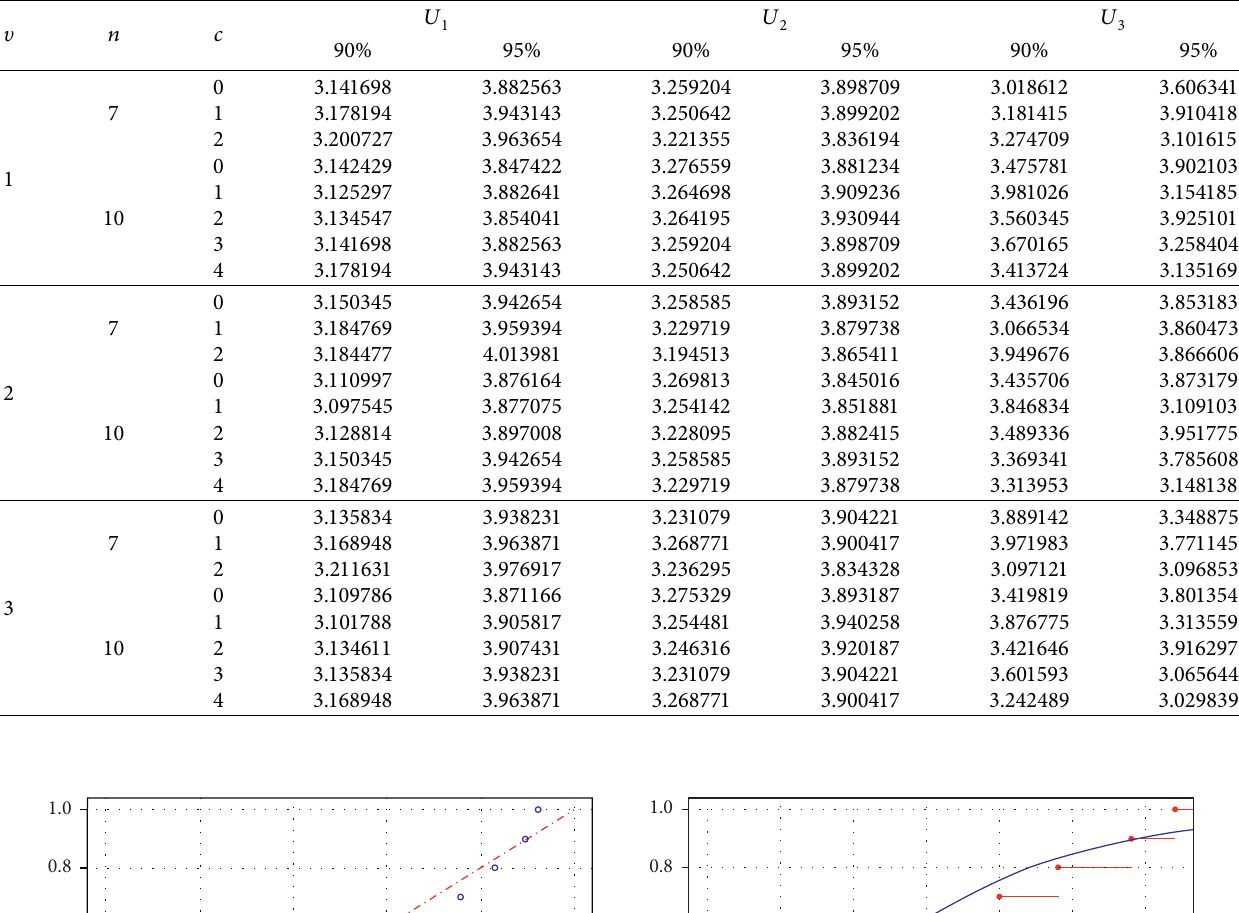
Table 8: Average width of the simulated